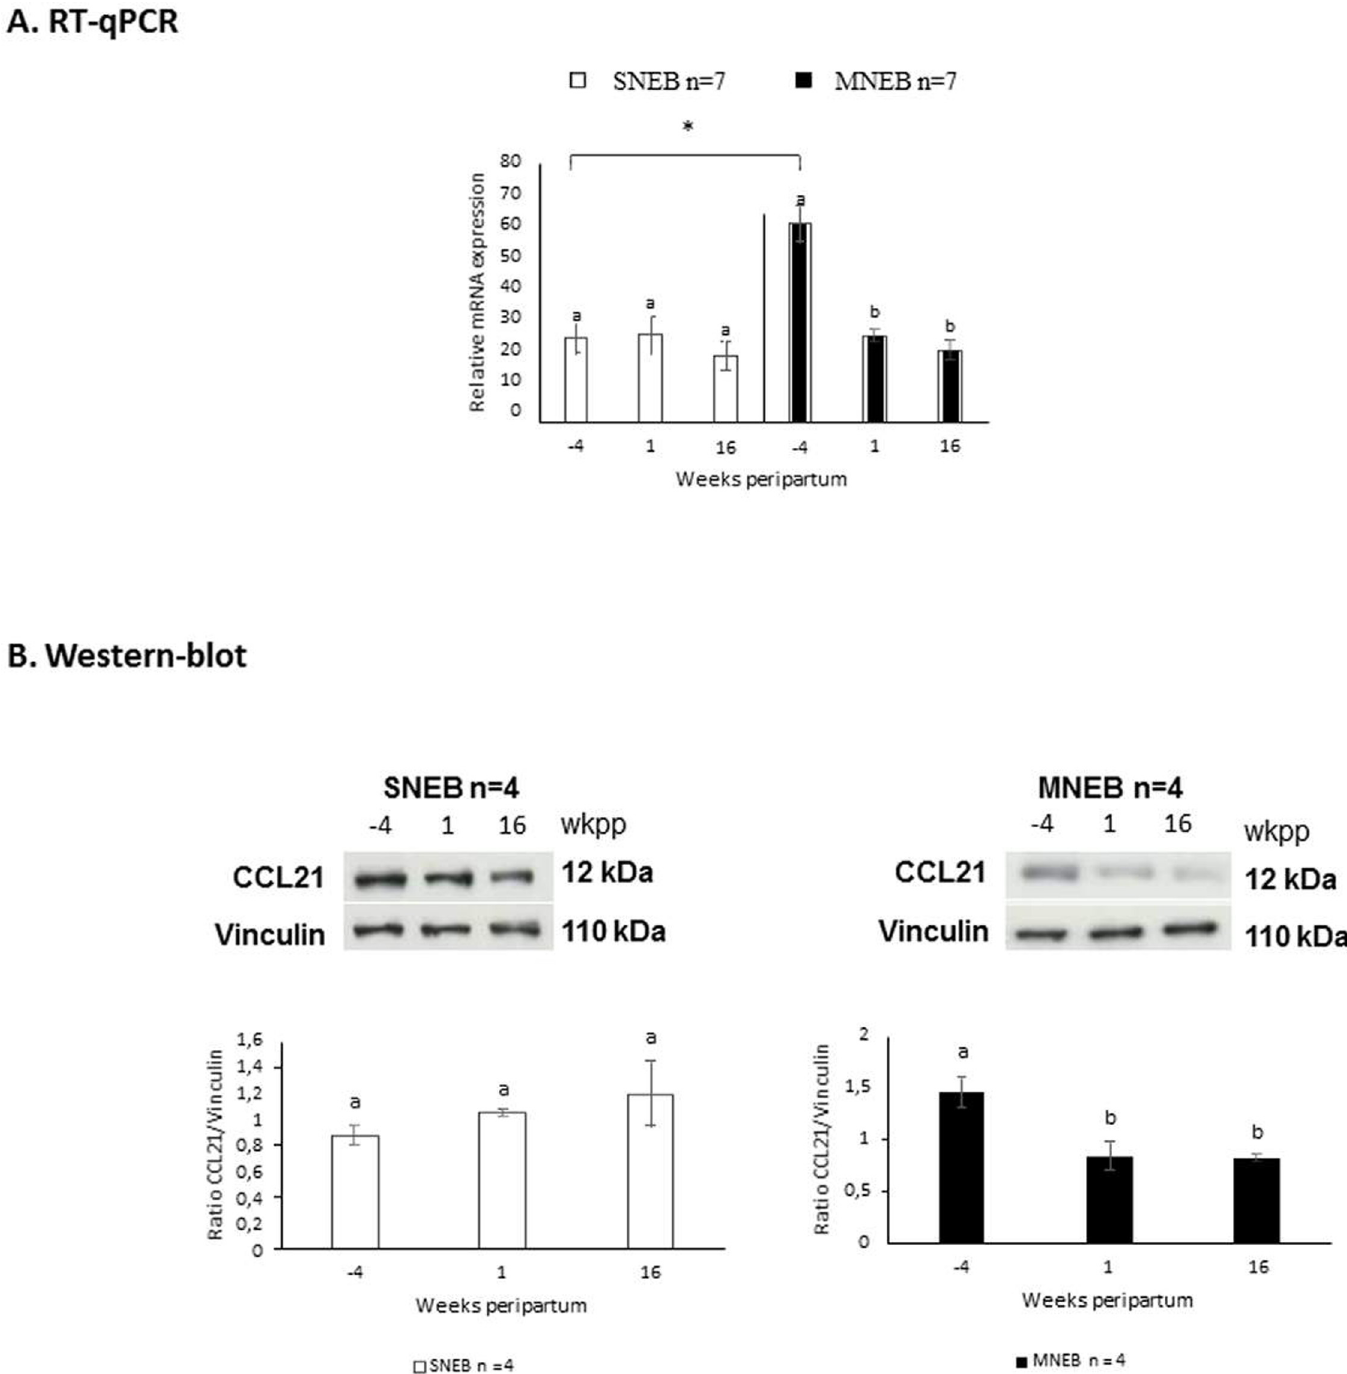
Fig 6. mRNA (A) and protein expression (B) level of CCL21 in subcutaneous adipose tissue of cows either with severe (SNEB) or moderate (MNEB) negative energy balance. A. Quantitative RT-PCR analysis for CCL21 was performed on subcutaneous adipose tissue samples collected at -4, 1 and 16 wkpp (n = 7 SNEB, n = 7 MNEB) as described in material and methods. B. Protein expression was determined by western blot using bovine anti-CCL21 antibody (12 kDa). Expression of vinculin (110 kDa) was used to normalize the expression of CCL21. Results are represented as LSM ± SEM. Low case letters represent significant effect of time separately in the group SNEB and MNEB ( P < 0,05). � P < 0,05 (effect of